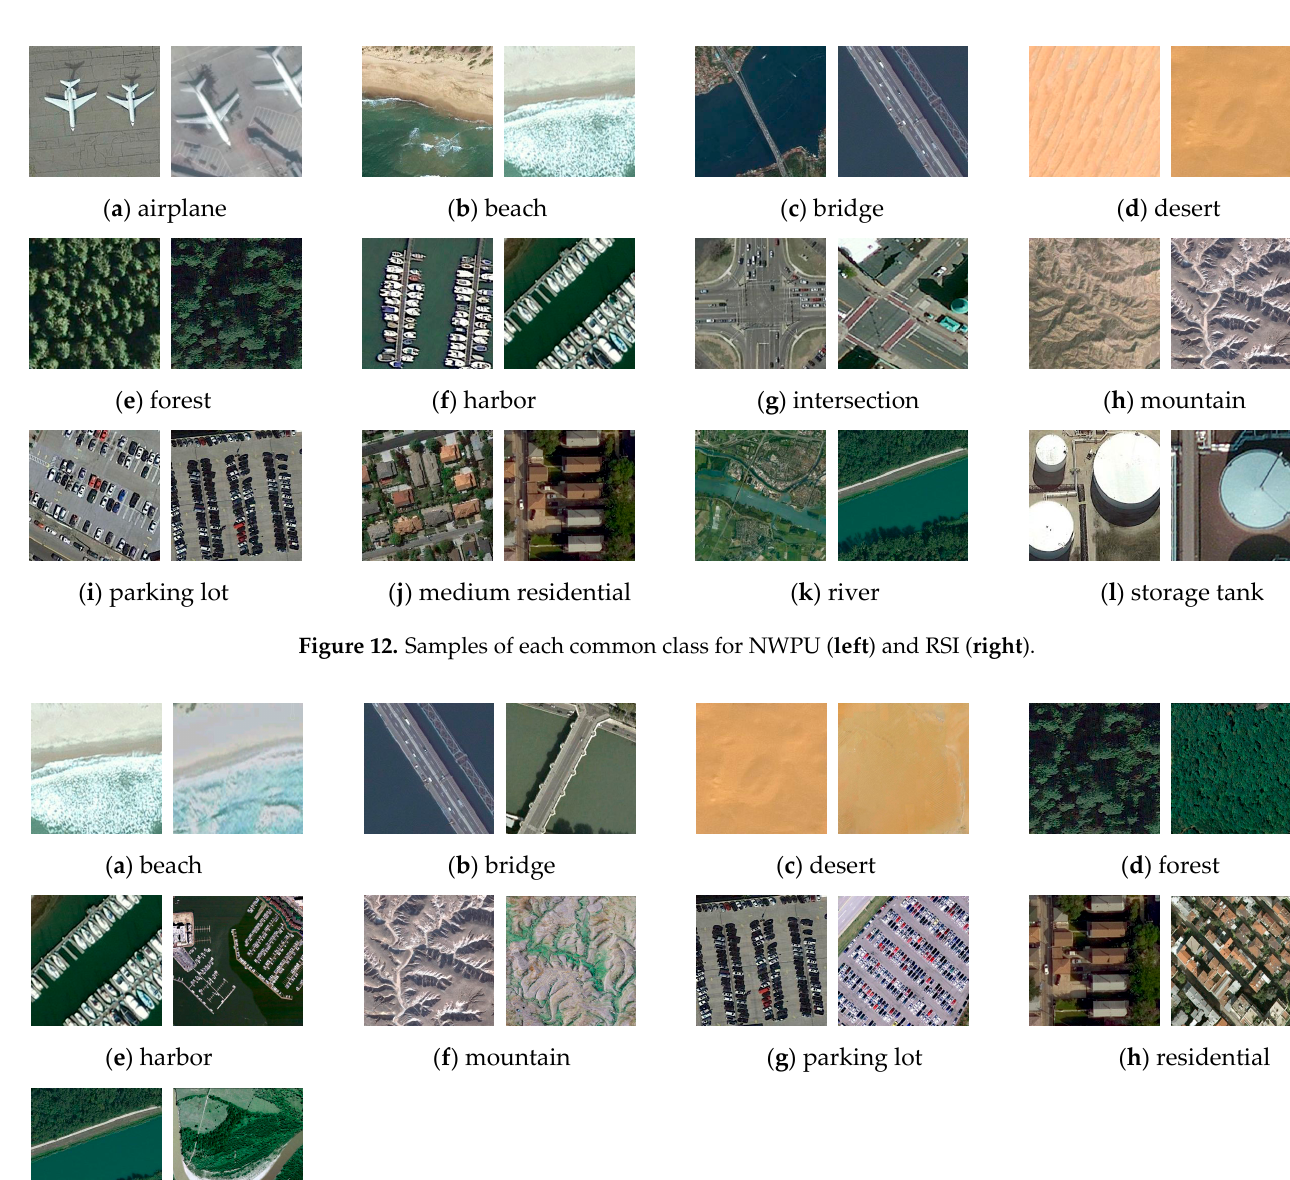
Figure 10. Samples of each common class for UCM ( left ) and WHU-RS19 (WHU) ( right ). ( a ) airport